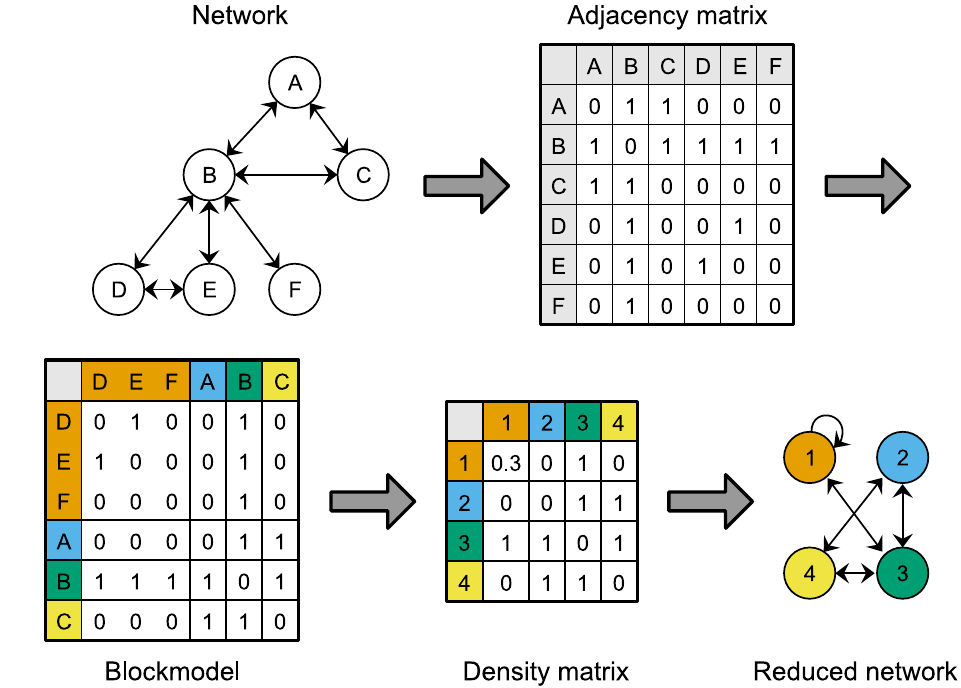
FIG. 2. Sample of blockmodel outputs. The network (top left) can be written as an adjacency matrix showing which nodes are linked (top right). The bottom row shows the blockmodeling products: a permuted adjacency matrix (left), the matrix showing each block density (center), and a reduced network where each diagonal block is treated as a node and inter- or intrablock links are present or absent according to a density